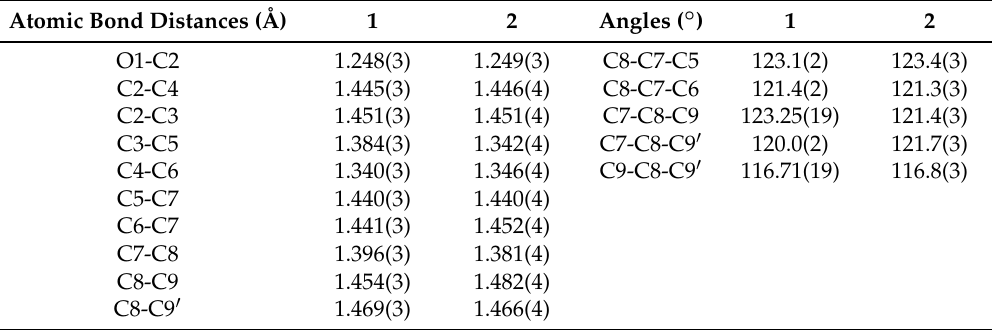
Figure 1. X-ray structures for ( left ) compound 1 and ( right ) compound 2 . Figure 2. X-ray structures for ( left ) compound 1 and ( right ) compound 2 . Table 1. Selected atomic bond distances and angles for compounds 1 and 2 . Table 1. Selected atomic bond distances and angles for compounds 1 and 2 .